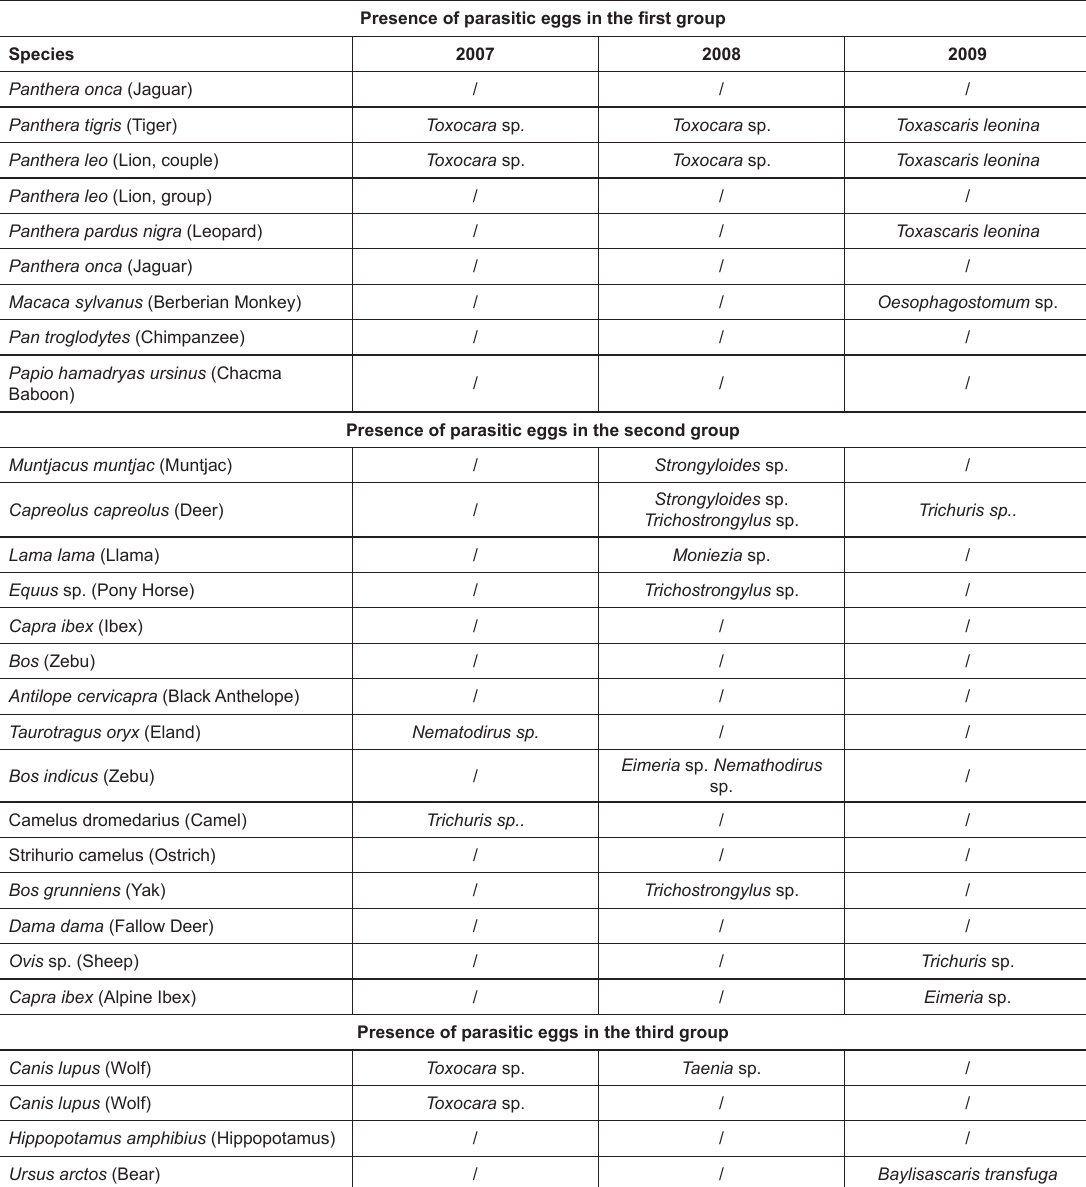
Table 1. Results of examination of the first, second and third